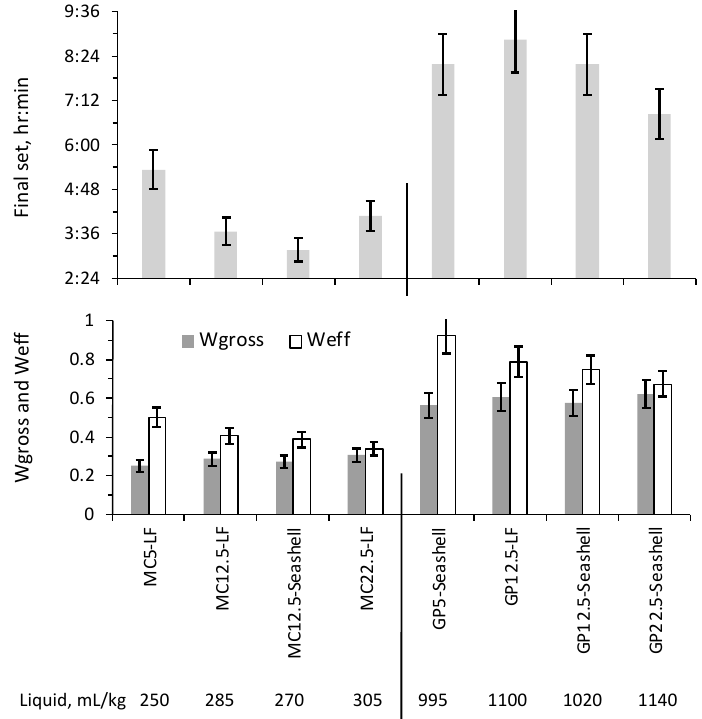
Figure 3. Variations in liquid demand, w gross , w eff , and final setting times.